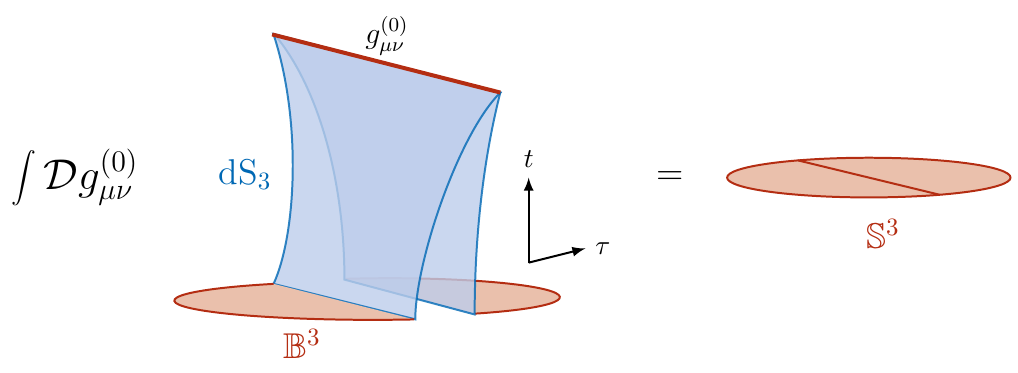
Figure 2 . A sketch of the path integral in the right-hand side of (1.12). The red and blue regions represent the Euclidean ( B 3 ) and Lorentzian ( dS 3 ) part of Hartle-Hawking wave functional Ψ dS , respectively. The Lorentzian parts of Ψ dS and its dual Ψ ∗ (cid:2) S 3 (cid:3) part Z G